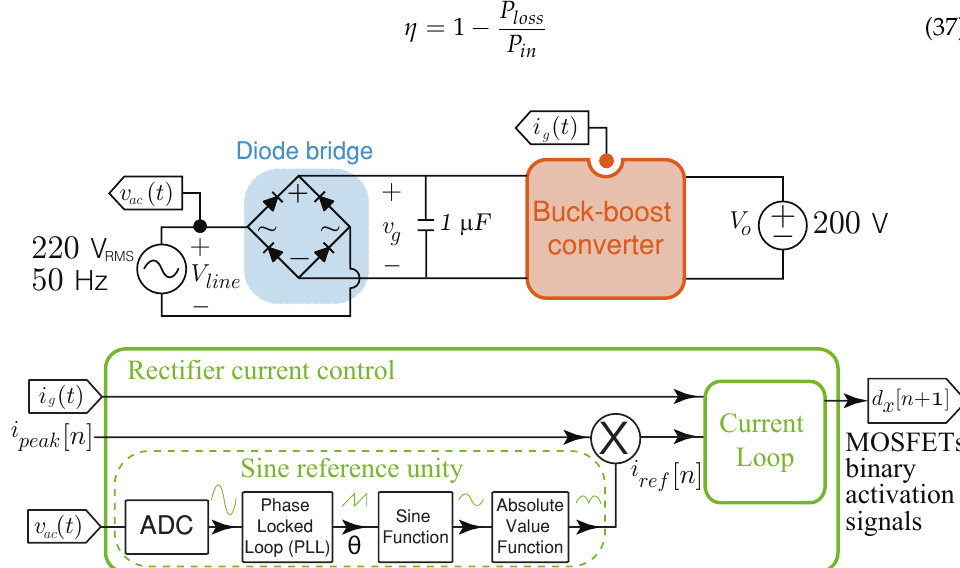
Figure 6. Block diagram of the buck-boost converter in an AC-DC application where its input current is